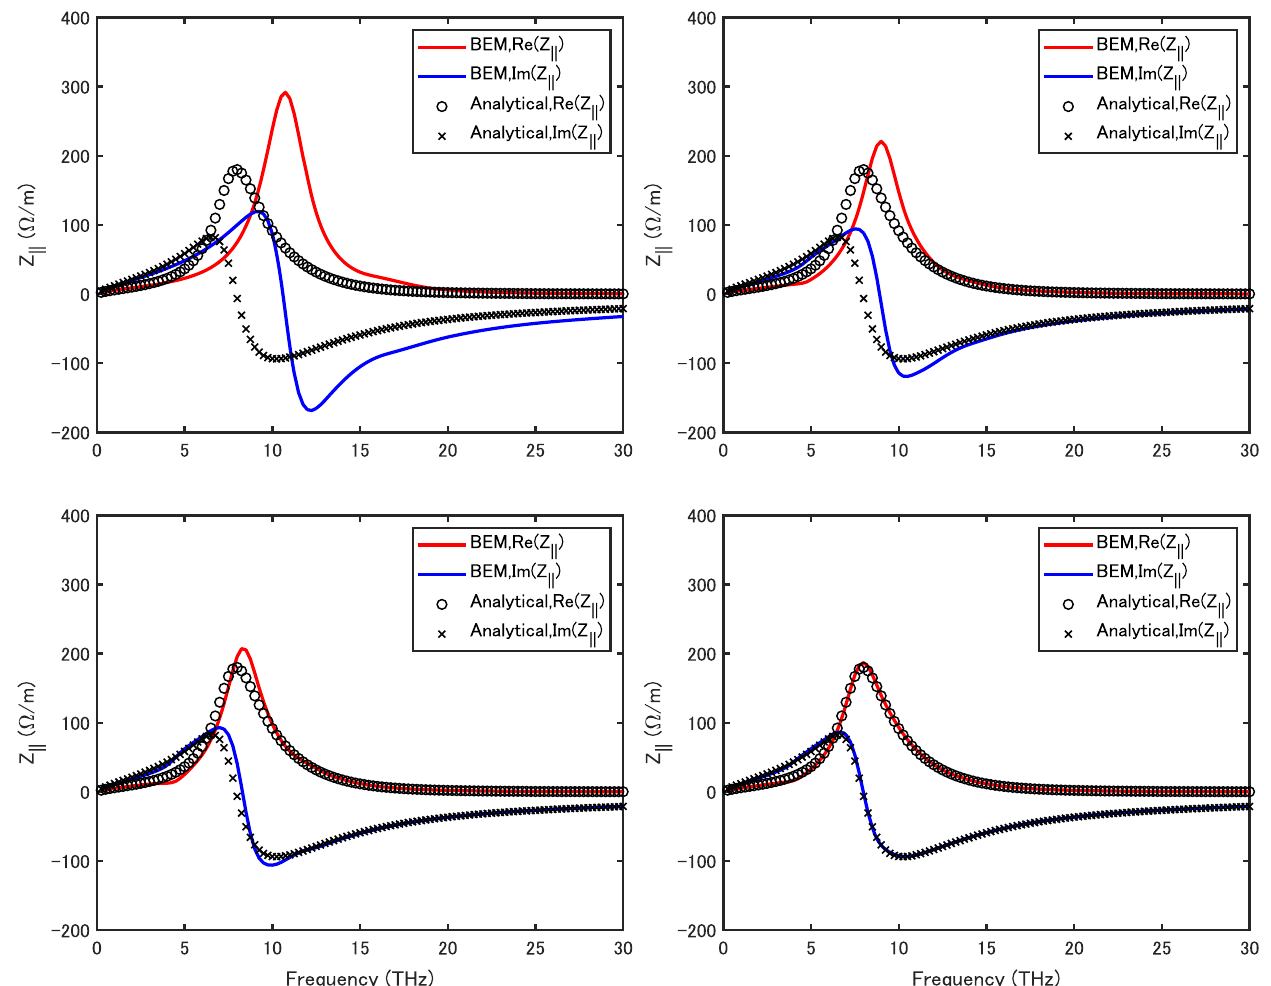
FIG. 7. ASE resistive-wall impedances for a uniform cylindrical beam with radius r b ¼ 0 . 1 mm and γ ¼ 10 000 and an aluminum rectangular vacuum chamber with height h ¼ 5 mm for different widths (top left) w ¼ h , (top right) w ¼ 2 h , (bottom left) w ¼ 3 h , and (bottom right) w ¼ 5 h . The analytical result of a parallel plate chamber with the same height is also displayed for